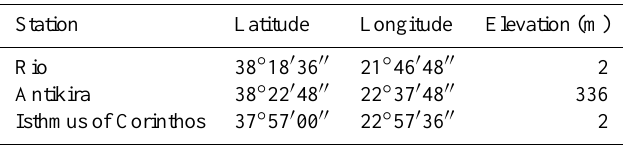
Table 1. List of stations and corresponding geographical